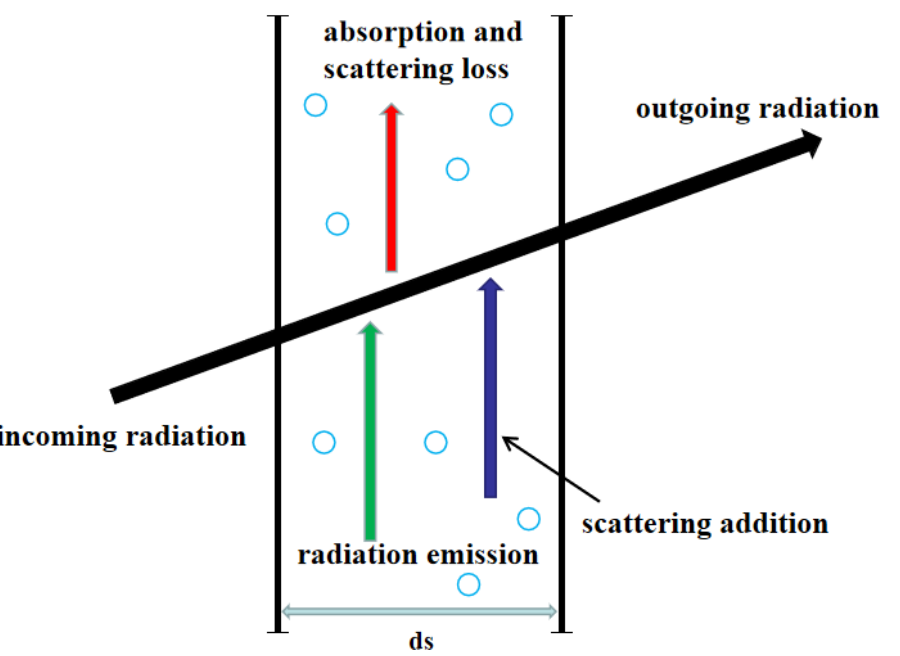
Figure 13. Schematic diagram of radiation heat